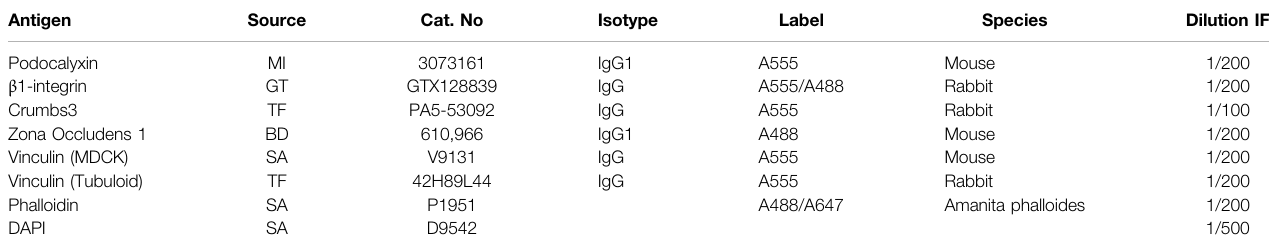
TABLE 1| Listofused antibodies anddyes.Abbreviationsusedinthistable:SA,Sigma Aldrich; BD,Biosciences;MI,Merck Millipore;GT,Gene-Tex; TF,Thermo-Scienti fi c. Antigen